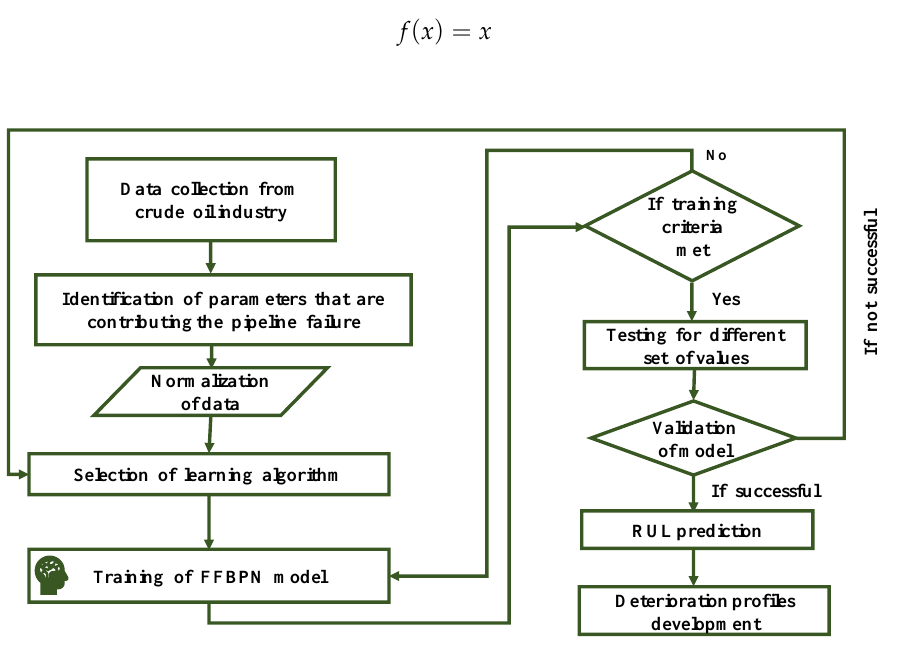
Figure 1. FFBPN approach workflow.